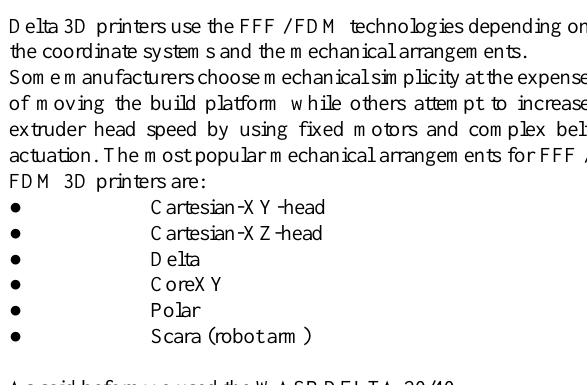
Figure 3. Textured 3D model carried out from Photoscan